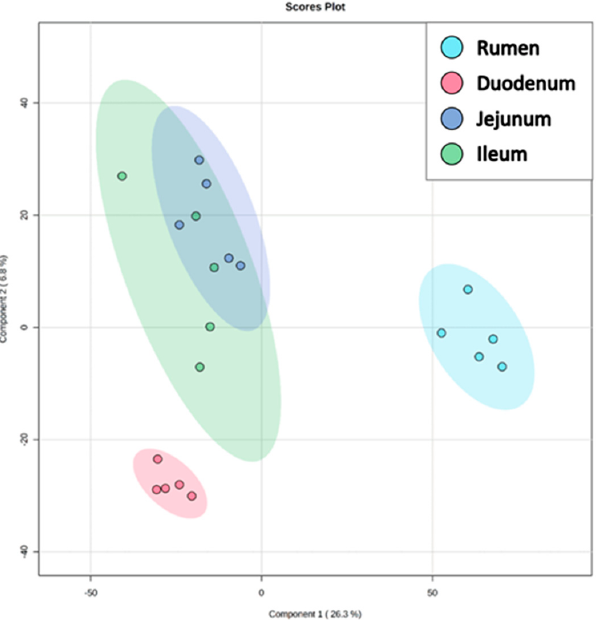
Figure 1. Classification ( A ) and distribution ( B ) of a total of 1259 lipid species identified across the ruminal papillae and epithelium from duodenum, jejunum, and ileum of 5 lactating Holstein cows.